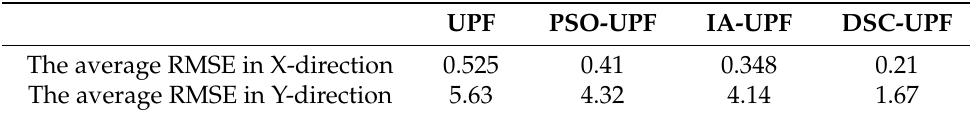
Table 1. The average RMSE of UPF, PSO-UPF, IA-UPF and DSC-UPF. UPF PSO-UPF IA-UPF DSC-UPF The average RMSE in X-direction 0.525 0.41 The average RMSE in Y-direction 5.63